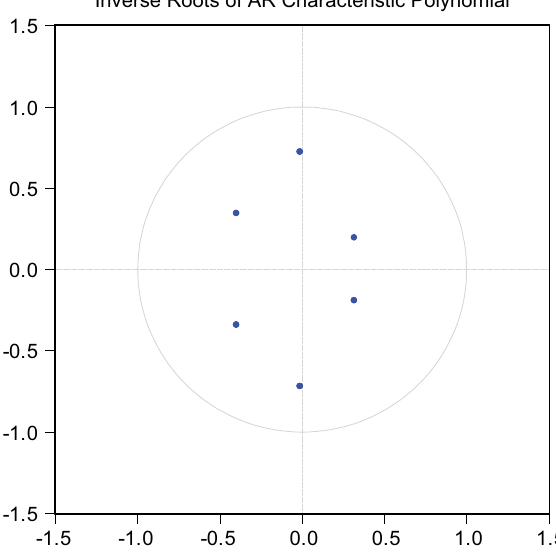
Figure 3: Parameter stability test. The parameters are stable – the points are con fi ned within the